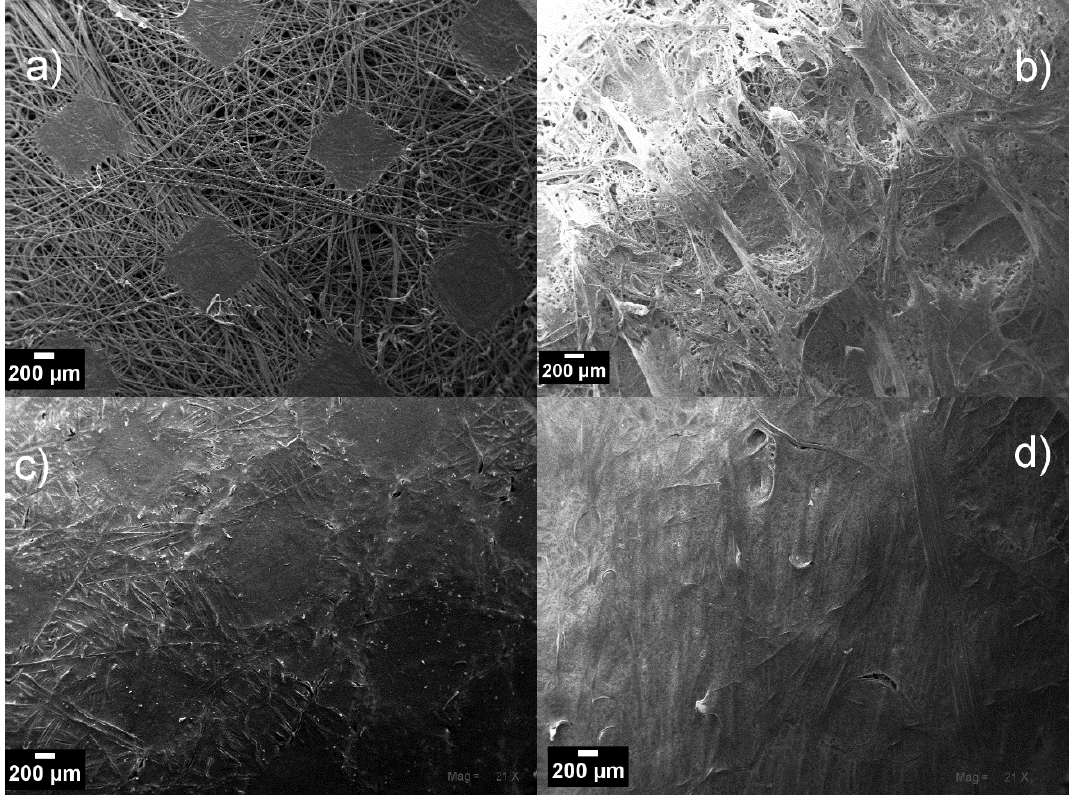
Figure 2. SEM micrographs of: ( a ) neat NWPET fiber; NWPET covered by depositing the casting solution at ( b ) 25 g/L, ( c ) 50 g/L, and ( d ) 200 g/L polyvinylidene fluoride (PVDF) concentrations. (Magnification 21 × ; scale bar 200 m.)